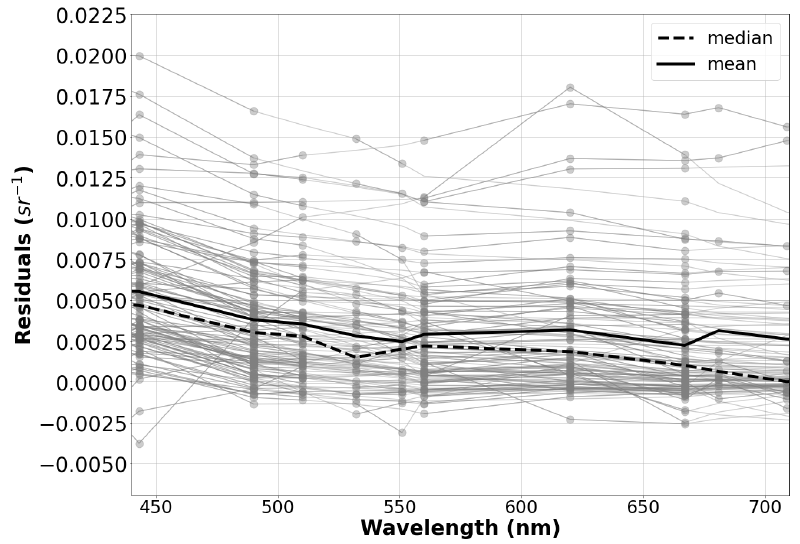
Figure 5. Residuals (Rrs PRISMA L2d − Rrs AERONET-OC ) obtained from the difference between PRISMA L2d and in situ measurements, in terms of Rrs (sr − 1 ). The continuous line represents the mean, while the dashed line represents the median.